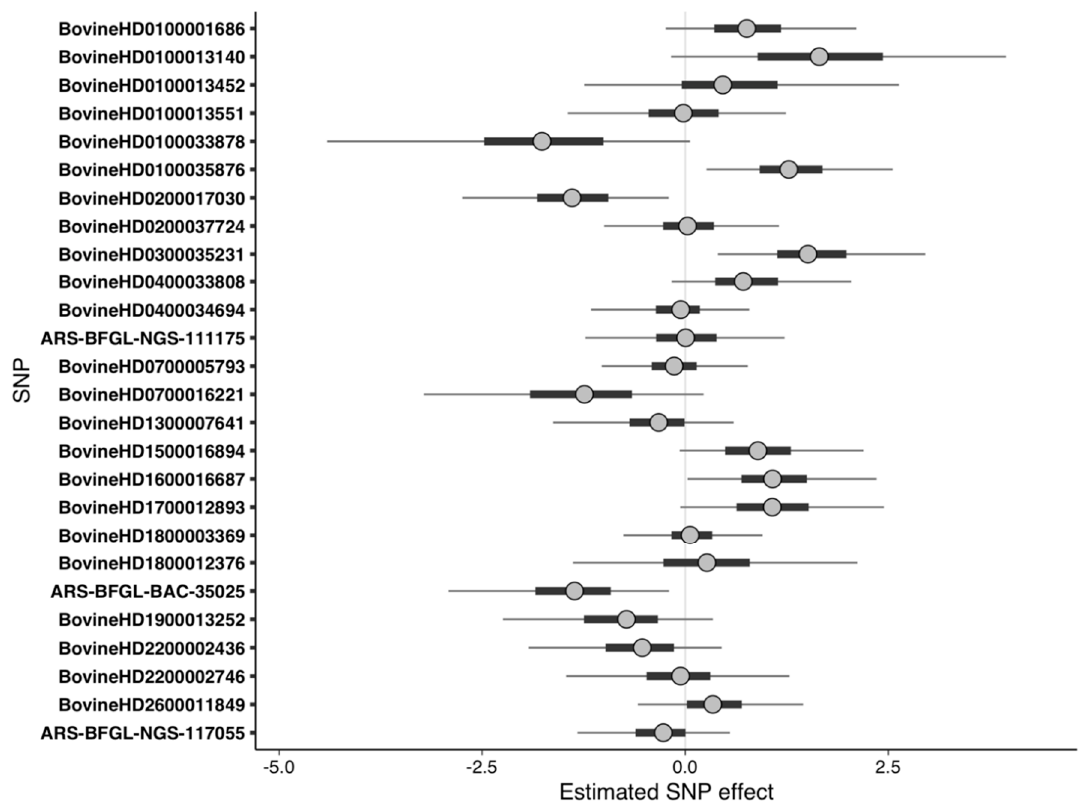
Figure 3. Uncertainty interval (UI) plot for important SNPs from the random forest analysis using binary phenotypes. Dots represent the median of the SNP effect estimates from the Markov chain Monte Carlo draws, thick bars indicate the 50% UI, and the thin lines indicate the 95% UI. SNPs with 95% UI not overlapping zero were considered significant. Positive values of predictor effect estimates indicate a higher risk of DD, whereas negative values indicate a lower risk of DD.